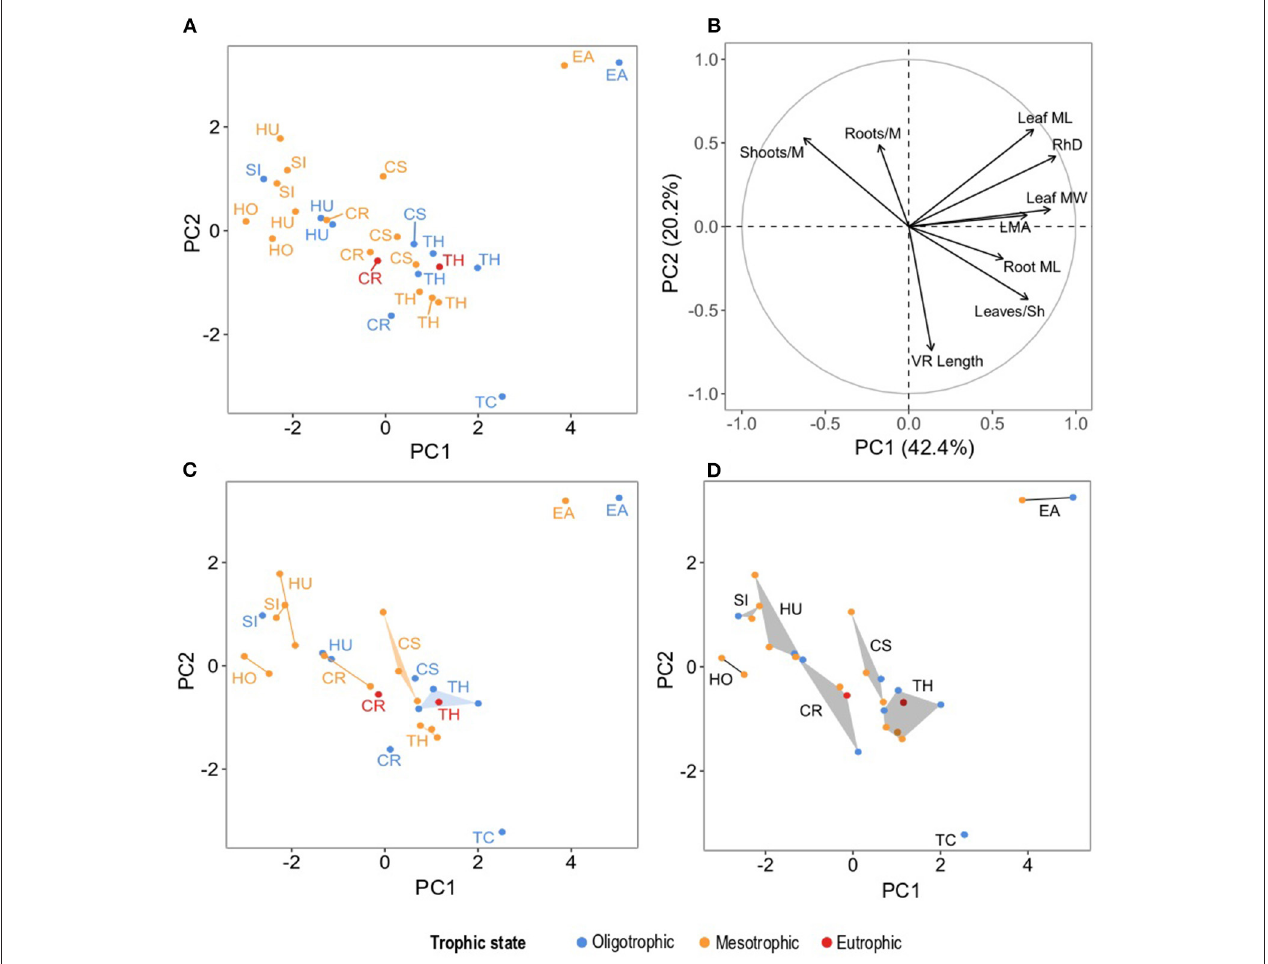
FIGURE 6 | Principal components analysis, (A) dots correspond to seagrass species per site plotted on PC1 and PC2 (which collectively explained 62.6% of the unconstrained variability), (B) traits as vectors and their correlation with PC1 and PC2 ( Table 5 for trait nomenclature and PCA output), (C) species’ hypervolumes per trophic state projected on PC1 and PC2, (D) species’ hypervolumes across all study sites projected on PC1 and PC2. For the graphical representation of PCs 3-6 see Supplementary Material 6 : Section 4. Colors represent trophic states and acronyms in (A,C,D) represent species’ names abbreviated as follows: CR, C. rotundata ; CS, C. serrulata; EA, E. acoroides ; HO, H. ovalis ; HU, H. uninervis ; SI, S. isoetifolium ; TC, T. ciliatum ; TH, T. hemprichii